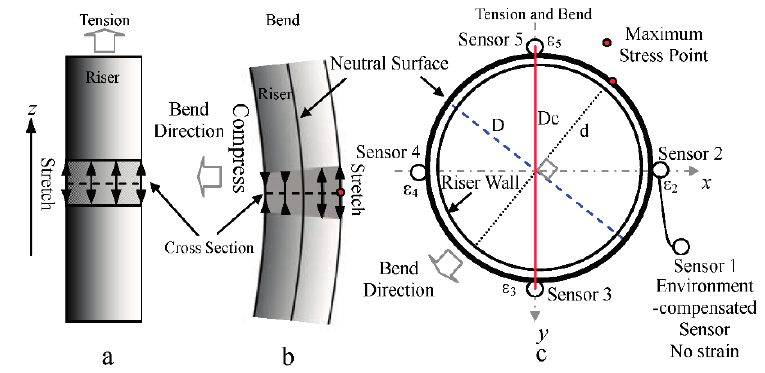
Figure 2. Schematic diagram of the sensing principle. ( a ) Riser in tension; ( b ) Riser under bending; ( c ) Locations of FBG